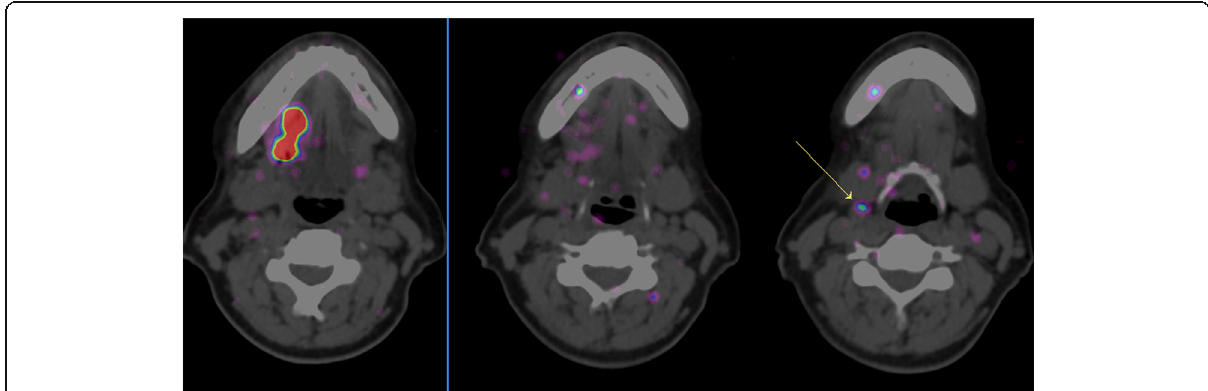
Fig. 3 Axial fused PET/CT images of patient 2 showing the injection site of 89Zr-nanocolloidal albumin in the lateral tongue on the right side and low uptake in SLN in level II